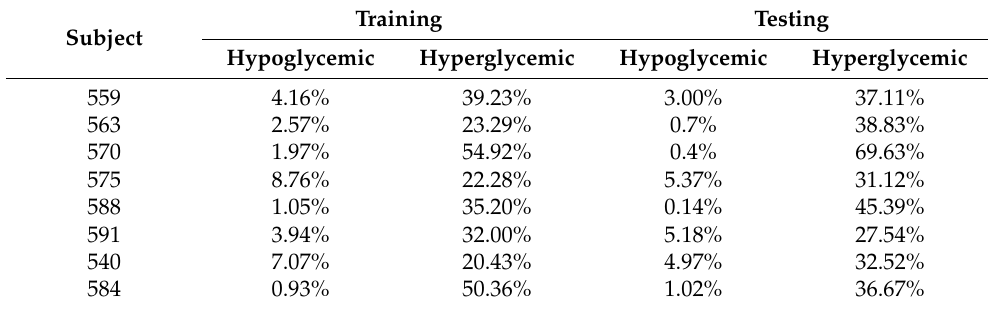
Table 2. Time in range of diabetes patients under study.